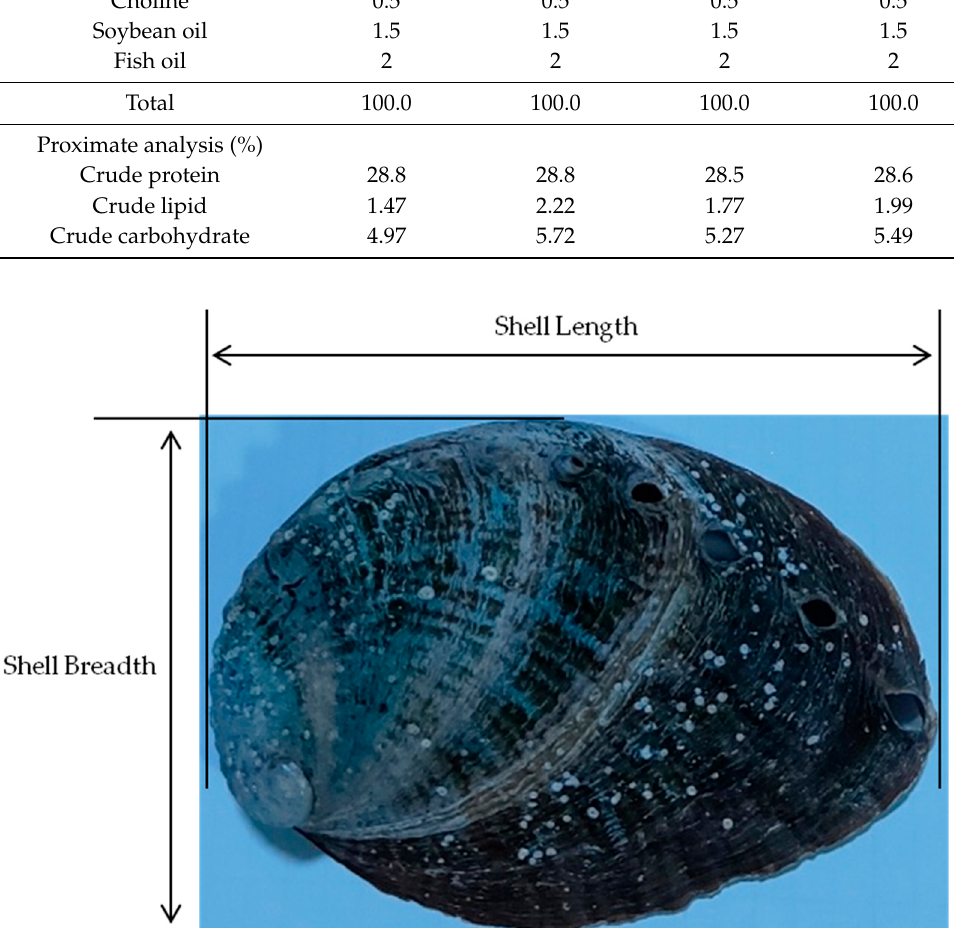
Figure 1. Abalone growth size measurement (sourced by the Author).